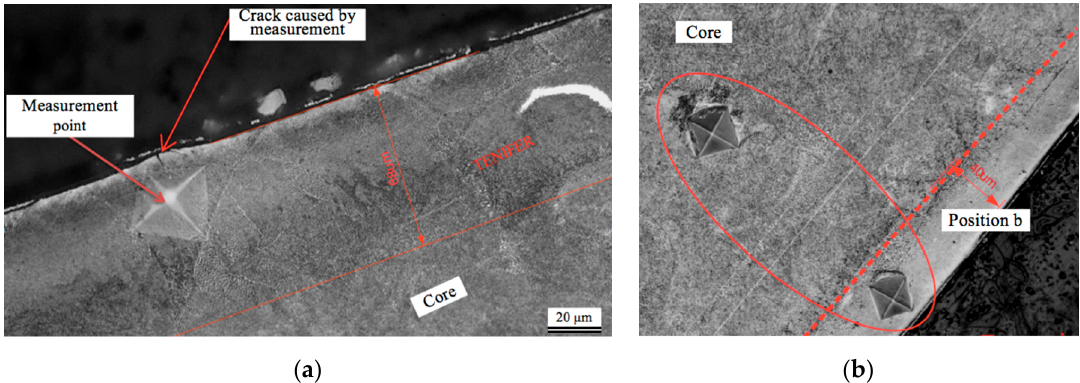
Figure 12. Photomicrograph of the microhardness measurement: ( a ) sample 1 with the measurement point a ; ( b ) sample 2 with the measurement point b . Table 2. Microhardness measurement results in di ff erent points. Hardness of Modified Layer in Its Middle [HV 0.5]